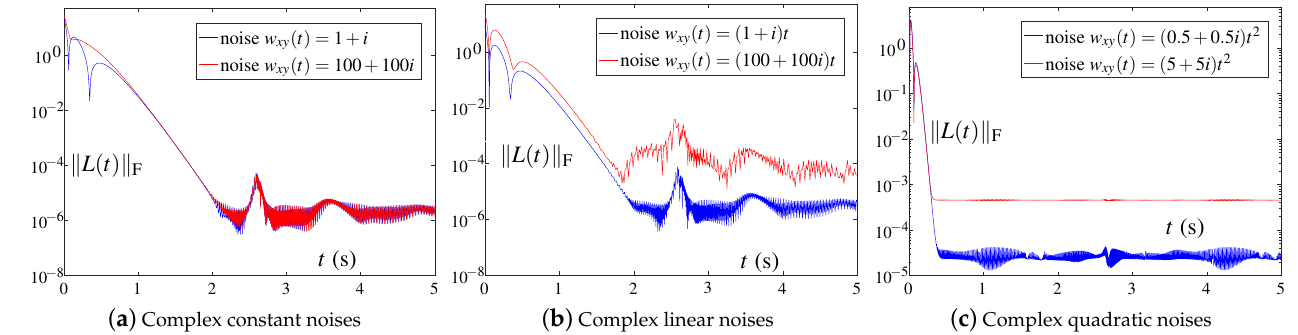
Figure 5. Residual trajectory of CNRZNN model (7) with ζ = 10 for solving CTDLE (15) under different noises. ( a ) Complex constant noises with different coefficients. ( b ) Complex linear noises with different coefficients. ( c ) Complex quadratic noises with different coefficients.